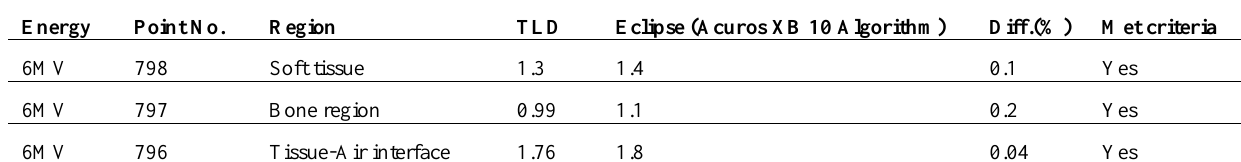
Table 2. The TLD measured doses and the Eclipse TPS calculated relative doses in the Nasopharynx region Energy Point No. Region TLD Eclipse (Acuros XB 10 Algorithm) Diff.(%) Met criteria